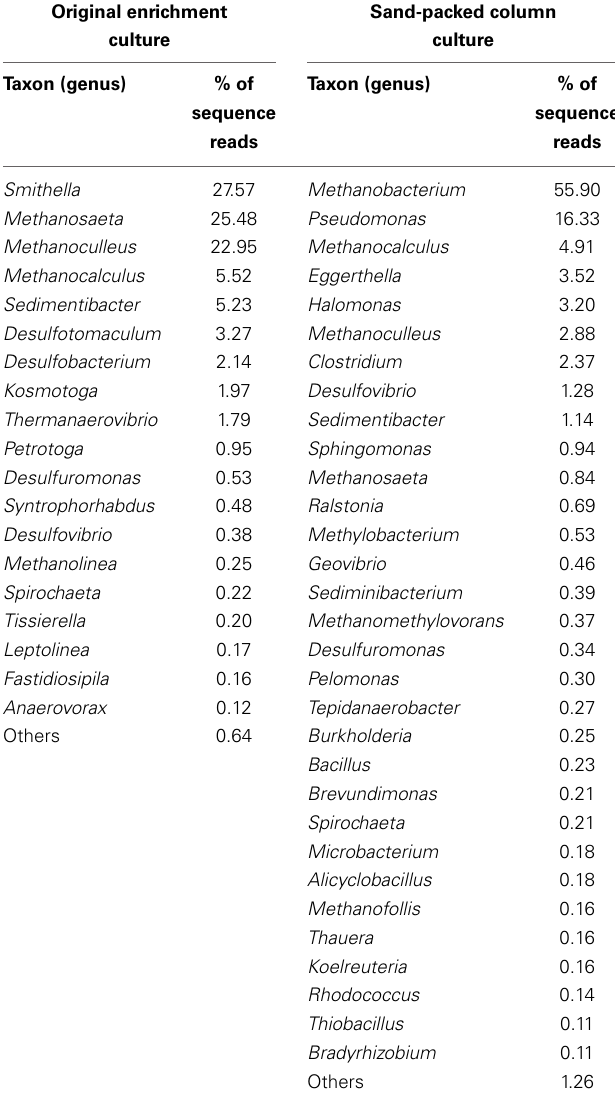
Table 1 | Phylogenetic affiliations of the microbial reads identified at the genus level (at > 0.1% abundance) by pyrosequencing of the 16S rRNA genes in the original oil-degrading methanogenic (planktonic) culture and after the inoculum was incubated in a sandstone-packed